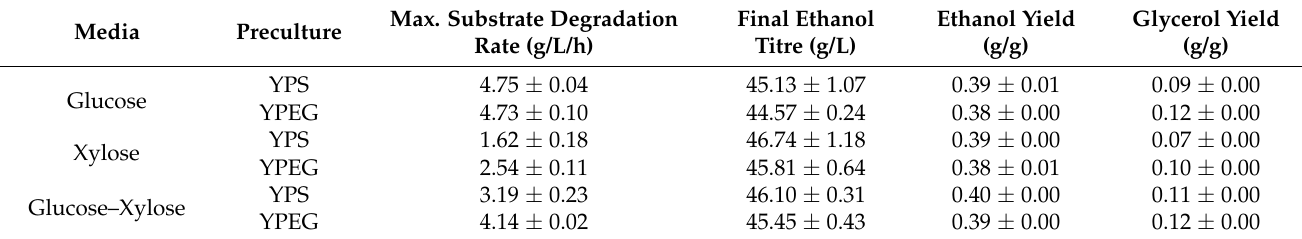
Table 1. Maximum fermentation rates and product yields at the end of fermentations on defined media in serum vials. The yeast was collected from a sucrose (YPS) preculture or an ethanol and glycerol (YPEG) preculture. The initial sugar concentration was 110 g/L, with a weight ratio of glucose to xylose of 3:2 in the medium containing both sugars. The substrates were fully depleted when experiments were ceased. Averages and standard deviations of three individual experiments are